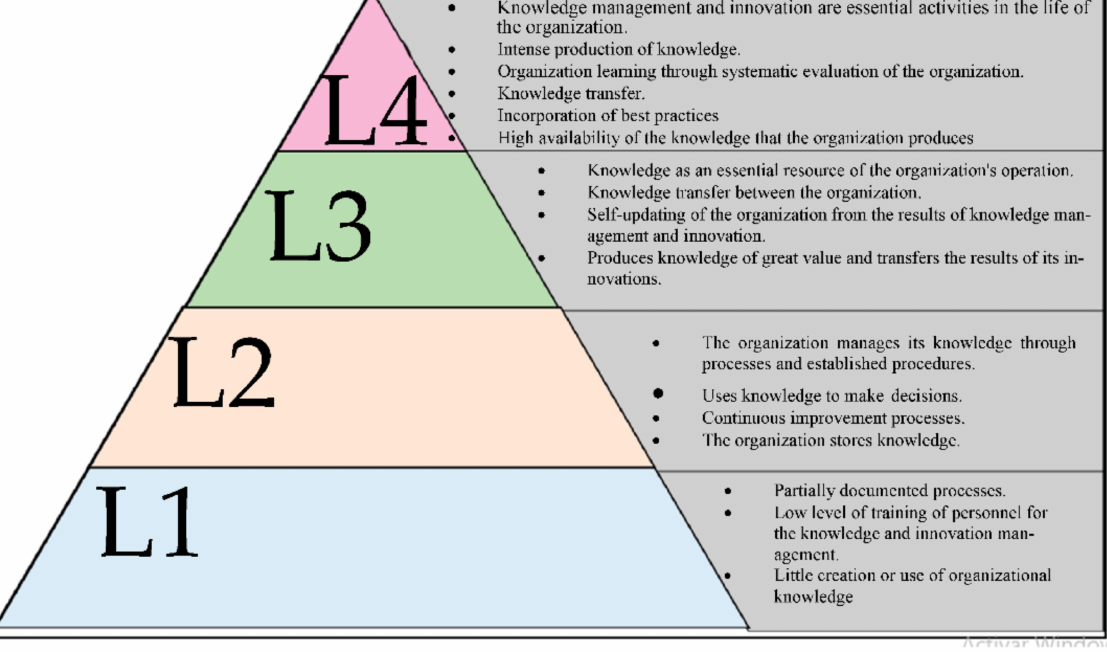
Figure 7. Summary of the elements that characterize the levels of the MSKMTI. Source: self-made.